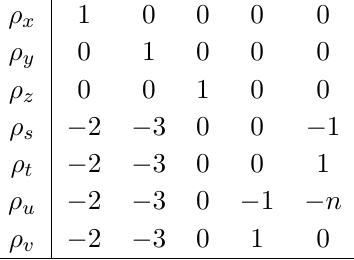
Table 2 . Toric data for ( O (cid:8) ( (cid:0) 2 K F